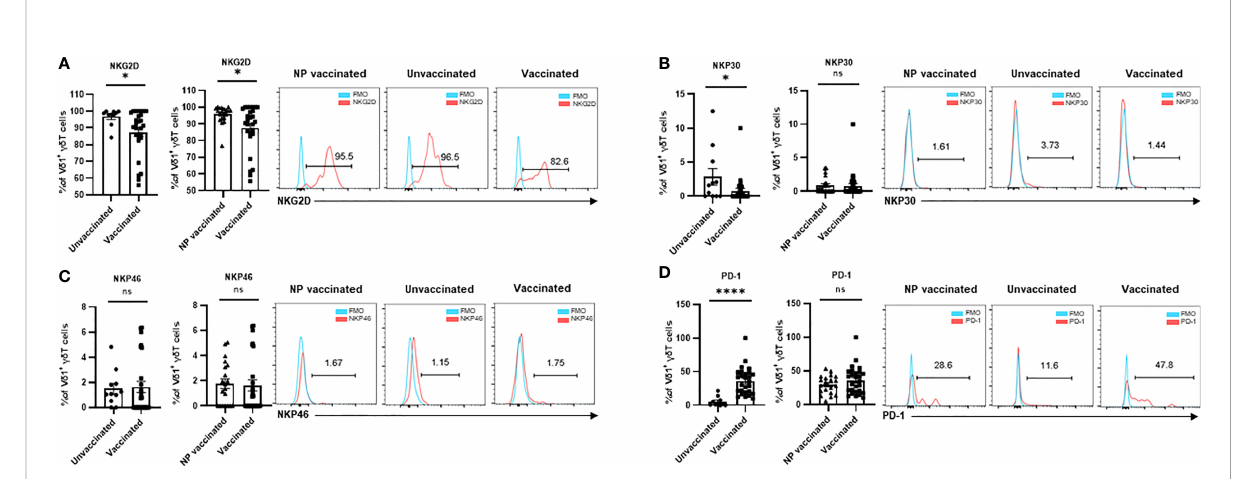
FIGURE 3 Expressions of crucial molecular of V d 1 + gd T cells in non-pregnant vaccinated women, vaccinated, and unvaccinated pregnant women. Comparable analysis of expressions of NKG2D (A) , NKP30 (B) ,NKP4 6 (C) , and PD-1 (D) receptors of V d 1 + gd T cells acquired by fl ow cytometry. ns, no signi fi cance; *P < 0.01; ****P < 0.001.